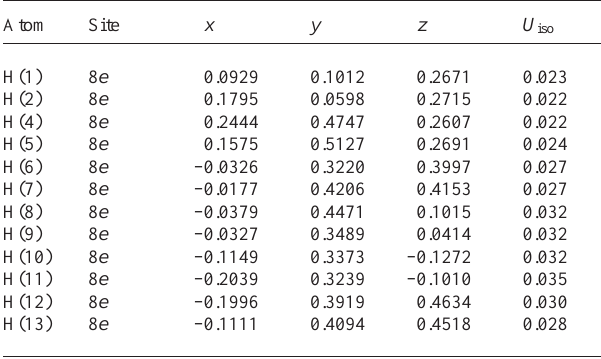
Table 2. Atomic coordinates and displacement parameters (in Å 2 )